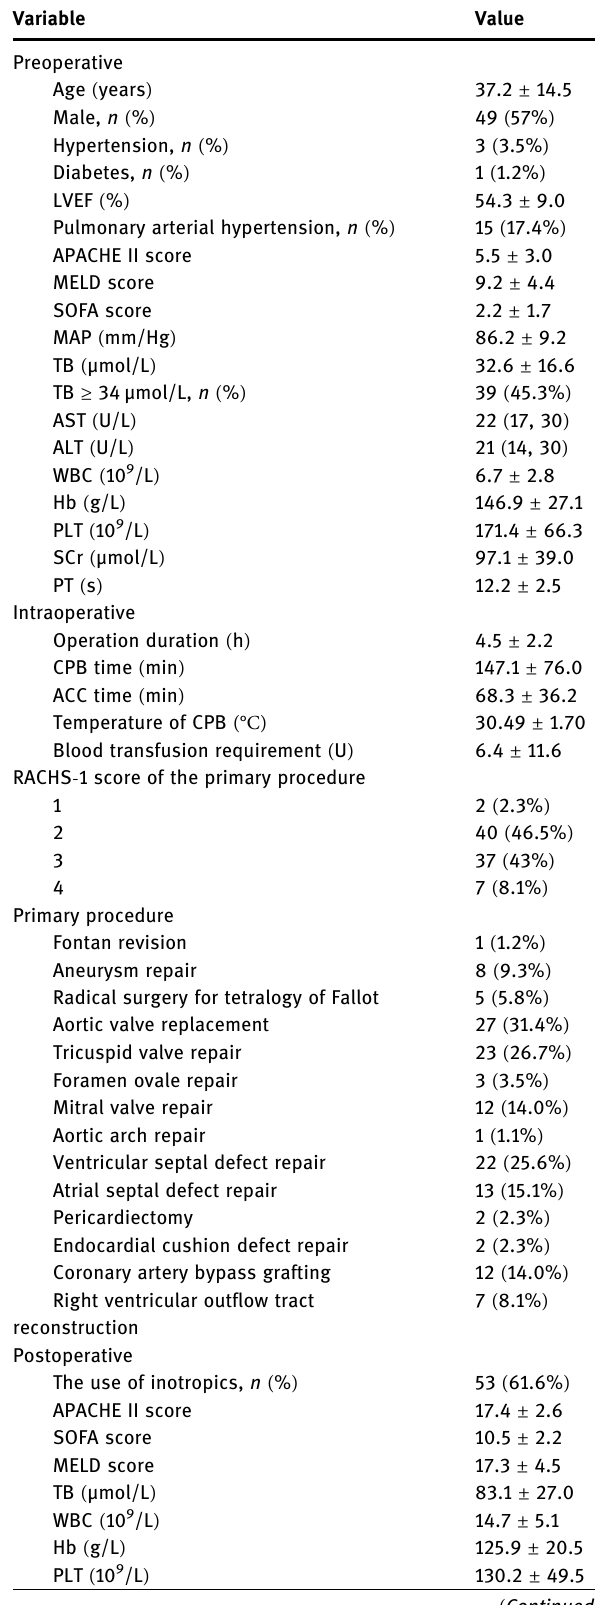
Table 1: Baseline characteristics of study